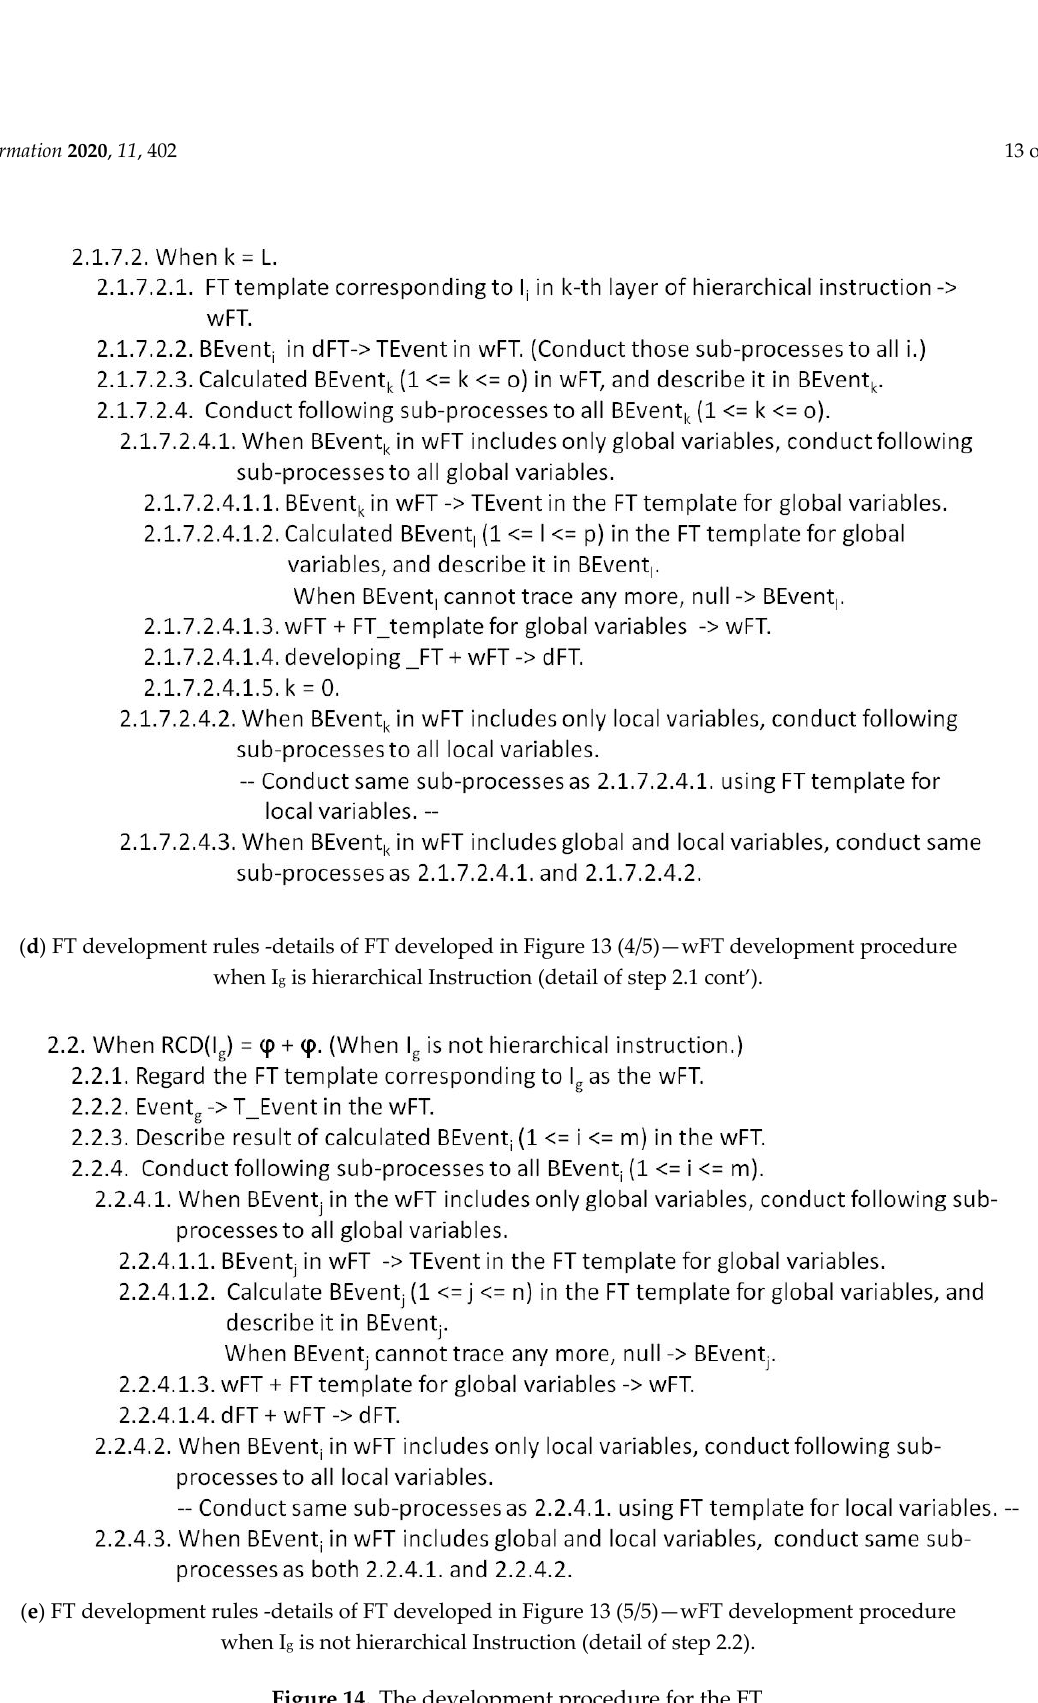
Figure 14. The development procedure for the FT.